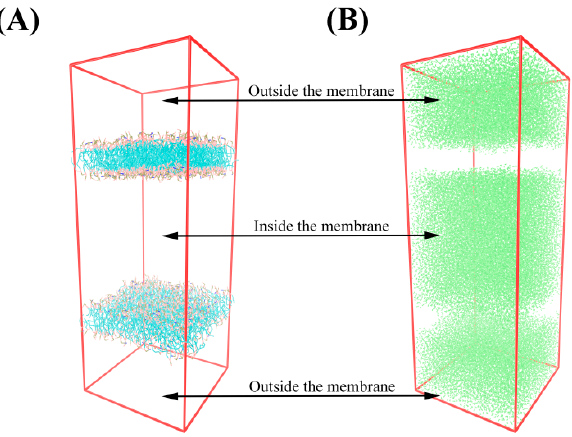
Figure 1. Bilayer model. ( A ) No water molecules. ( B ) Only water molecules. The molecular information on α -lactalbumin (PDB: 1HFZ) [32] and β -lactoglobulin (PDB: 3NPO) [33] and the major components of whey protein were provided by the RCSB Protein Data Bank. All topologies of ε -PL (degree of aggregation = 25), POPE, and POPG for GROMACS were generated by CHARMM-GUI [34] and then modified according to the Martini force field requirements.